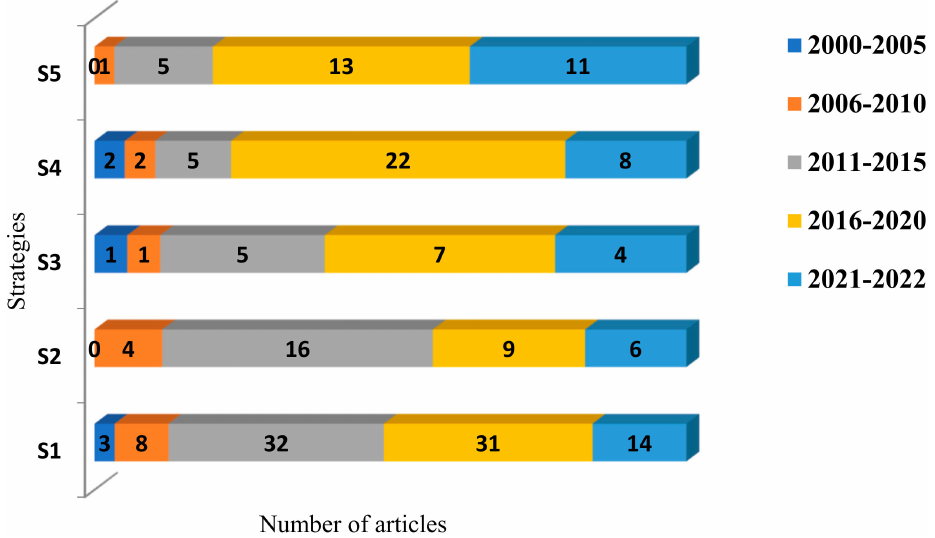
Figure 9. Strategies selection in previous research works according to the published year.